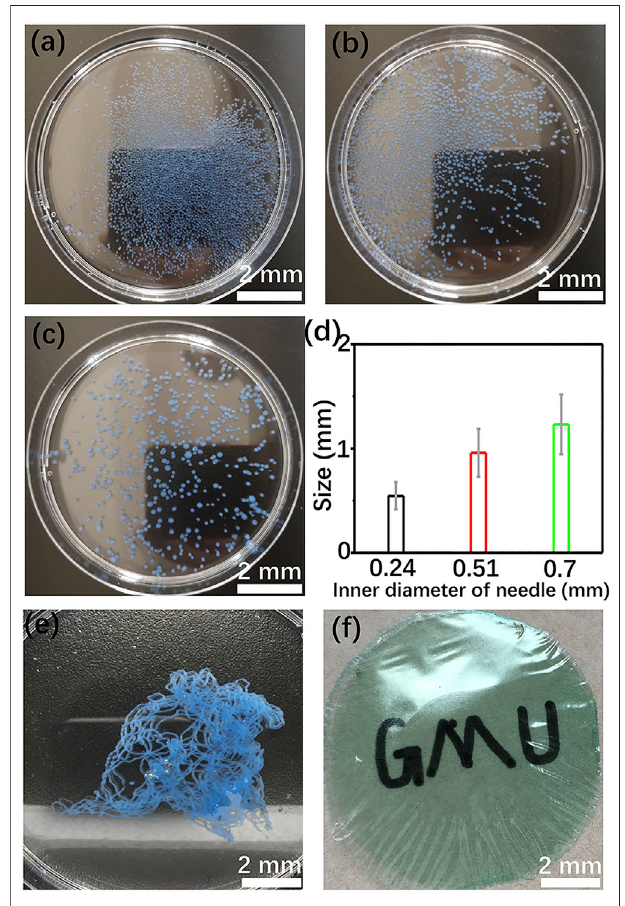
FIGURE 1 | Cu/GG spheres prepared with different sizes of the syringe needle (A – C) ; (D) sizedistributionofthese hydrogel spheres; (E) Cu/GG fi ber; (F) Cu/GG